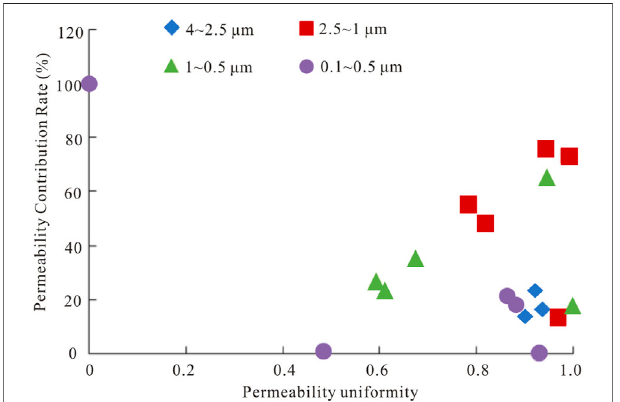
FIGURE 10 | Relationship between pore-throat heterogeneity at different scales and movable fl uid saturation.